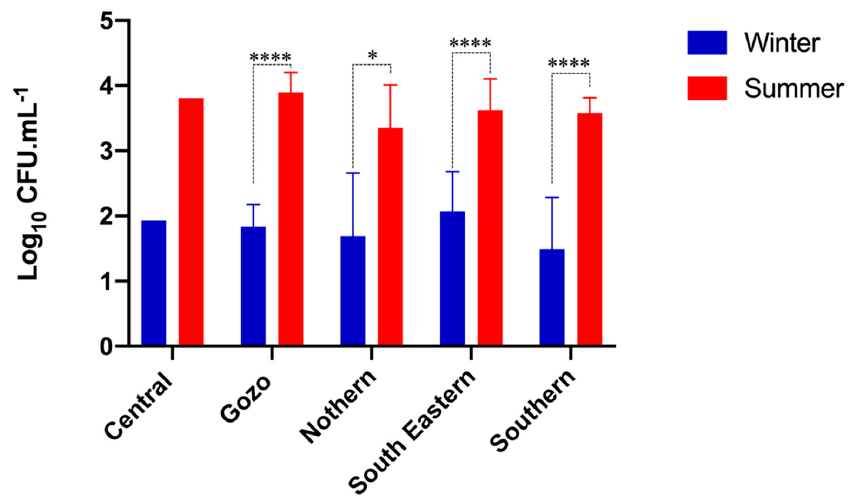
Figure 2. Average lactic acid bacteria counts (LSA counts) presented per geographical region for winter and summer seasons (* p < 0.05, **** p <